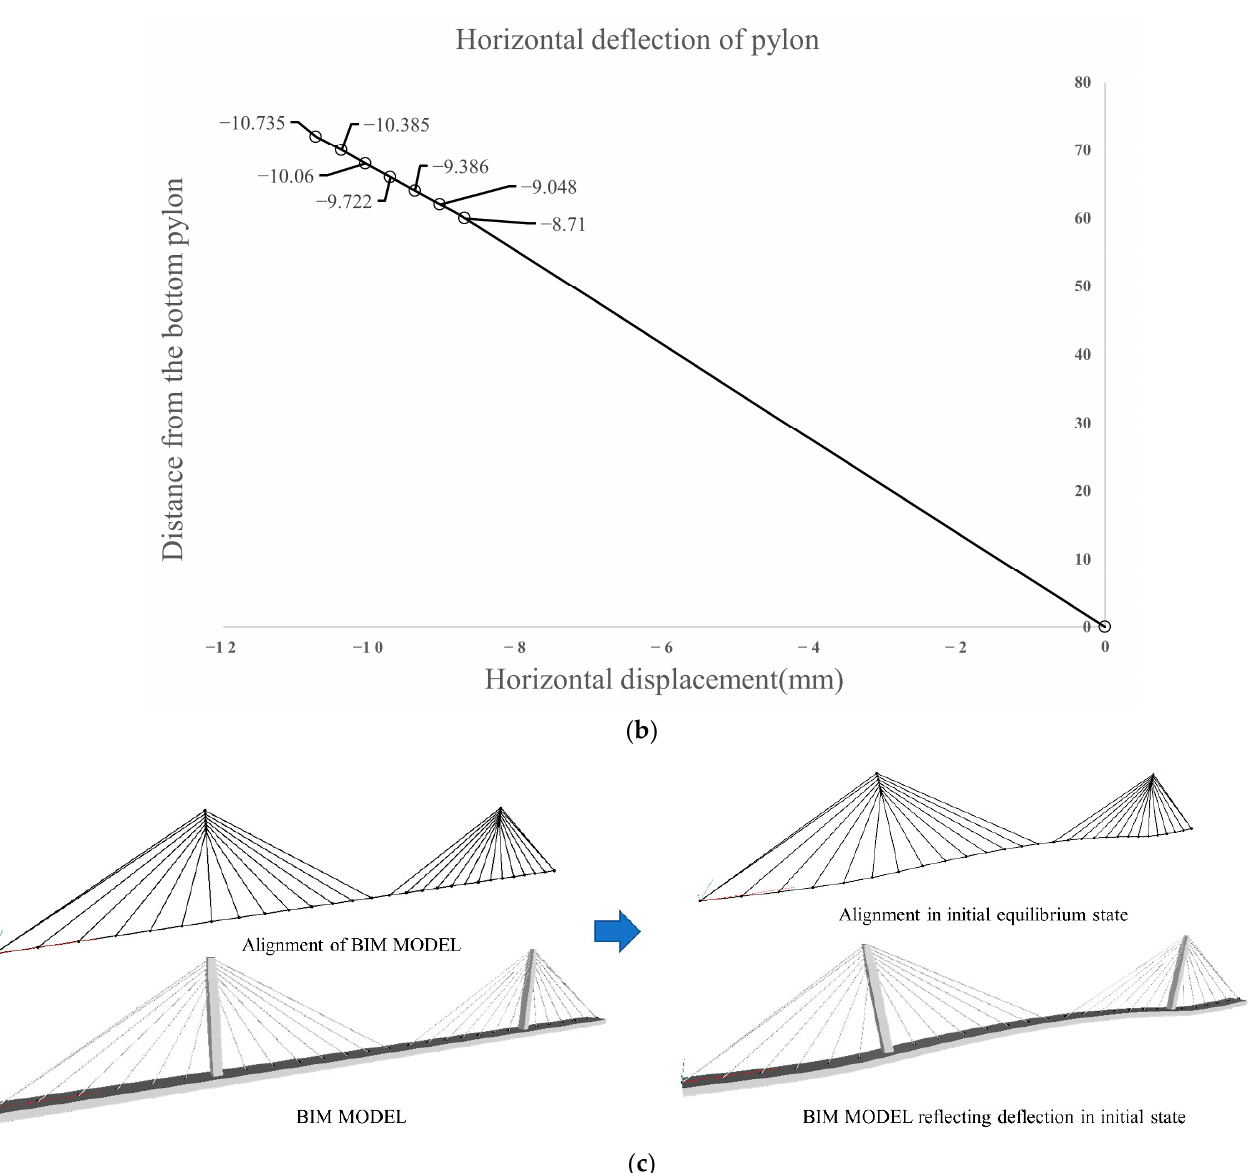
Figure 16. Two-way interoperability between BIM and finite element analysis (FEA): ( a ) Vertical deflection of stiffening girder in initial equilibrium; ( b ) Horizontal deflection of pylon in initial equilibrium; ( c ) Deformed shape revision using analysis results.